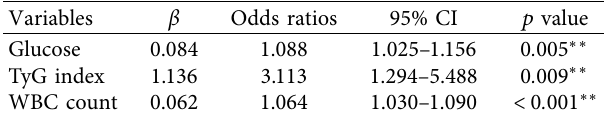
† Adjusted for the covariates age and gender, when SNP BDNF G196A (the absence vs. the presence of the A allele) or SNP BDNF C270T (the absence vs. the presence of the T allele) was used as a dependent variable. ∗ p < 0 . 05. Table 4: Genotypic and allelic distribution of the single nucleotide Table 5: Logistic regression analysis with obesity used as a de- polymorphisms BDNF G196A and C270T in nonobese and obese pendent variable and age, sex, brain-derived neurotrophic factor children. concentration, glucose, triglyceride-glucose (TyG) index, non- high-density lipoprotein cholesterol, white blood cell (WBC) count, the single nucleotide polymorphisms BDNF G196A, and Obese C270T used as independent